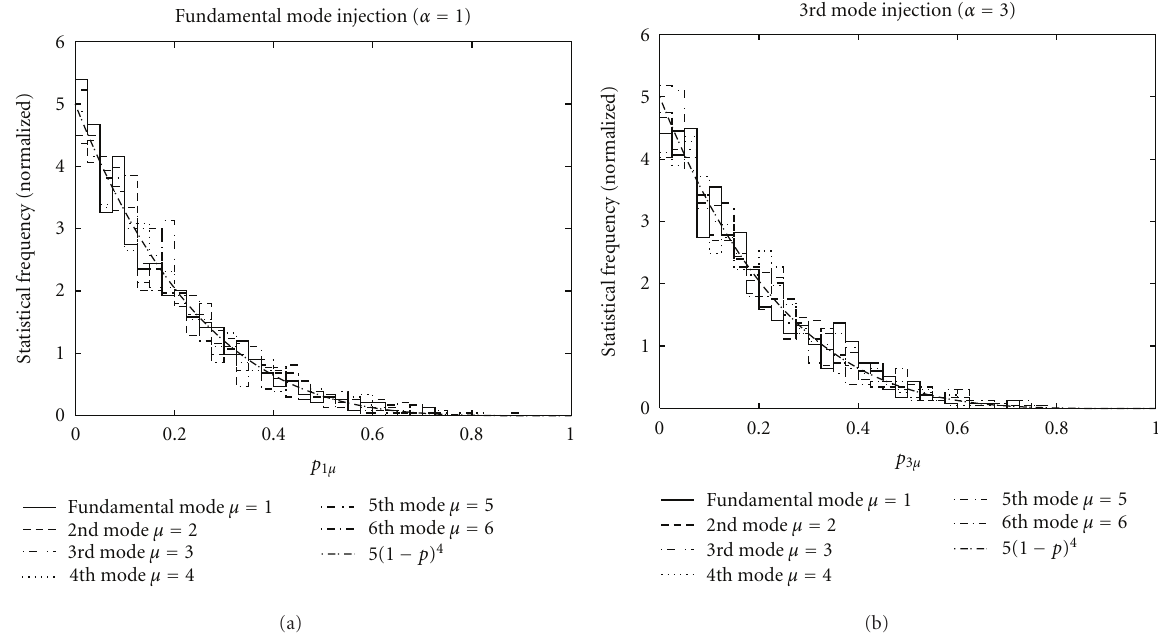
Figure 17: The frequency distribution for the fraction of each propagating mode in the transmission current for the fundamental and third √ mode incidence, respectively; Kd = 150 π , (cid:4) B =